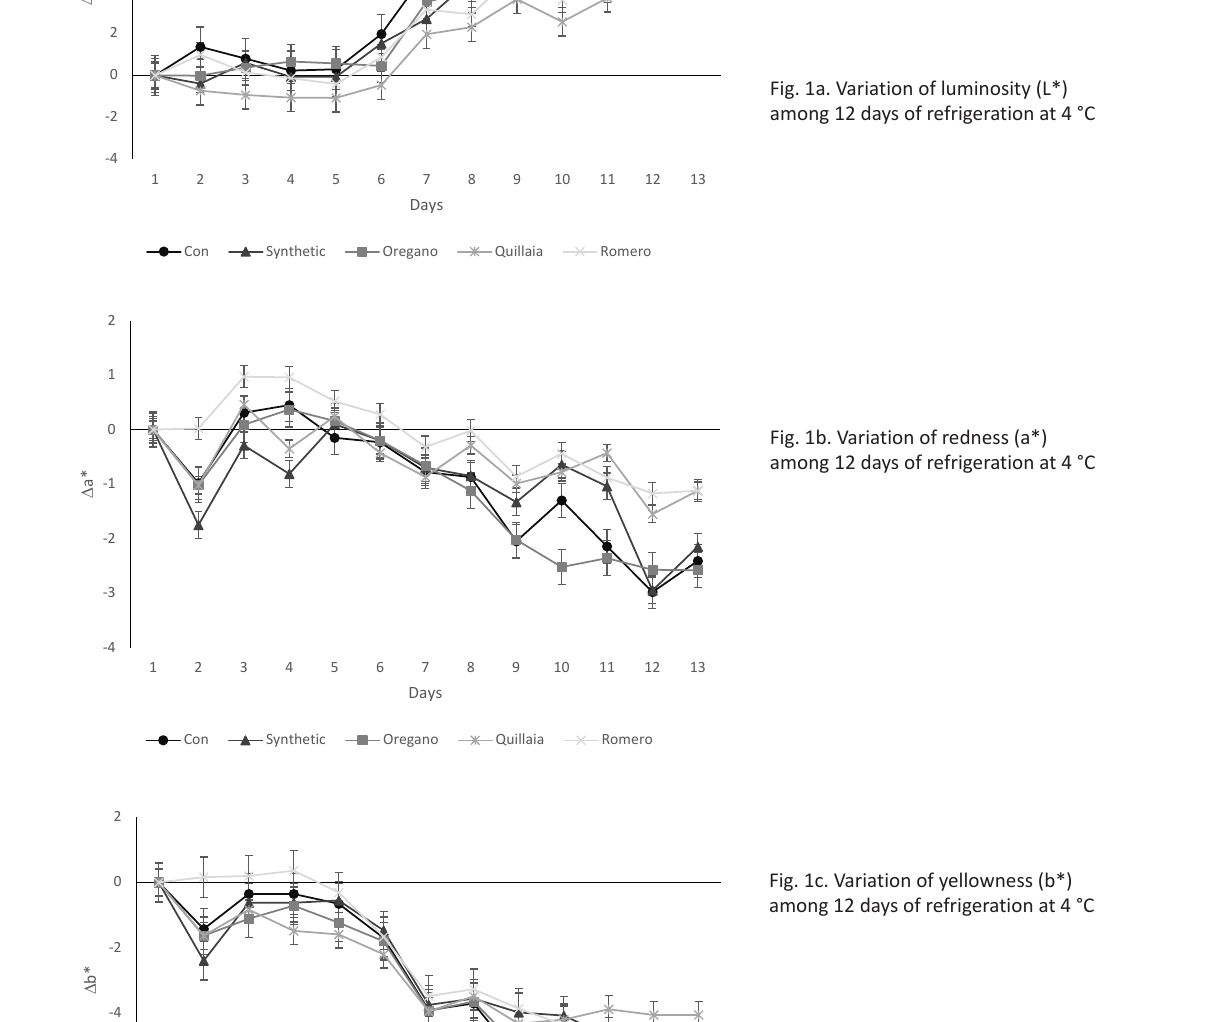
Fig. 1c. Variation of yellowness (b*) among 12 days of refrigeration at 4